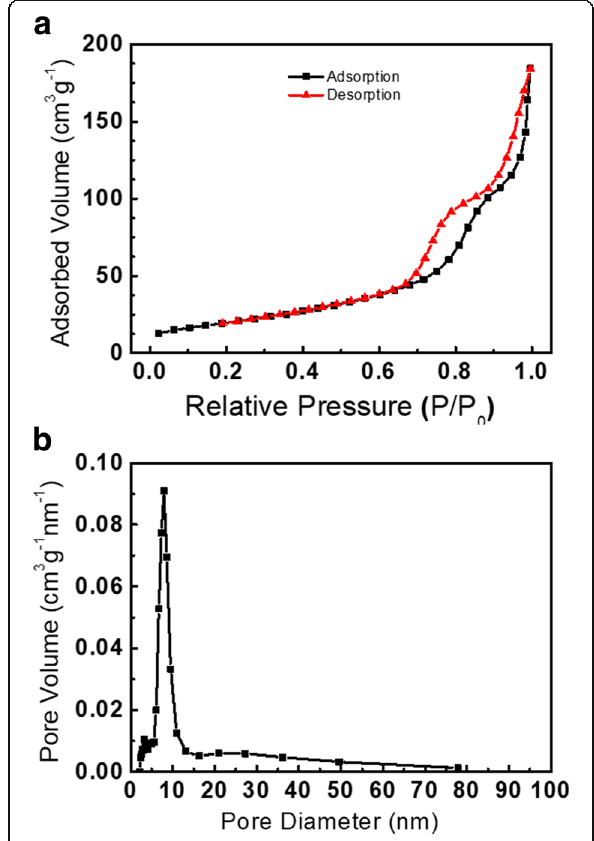
Fig. 5 a Nitrogen adsorption and desorption isotherms and b pore size distribution of sea urchin-like NiCo 2 O 4 synthesized with 5 g PDDA solution